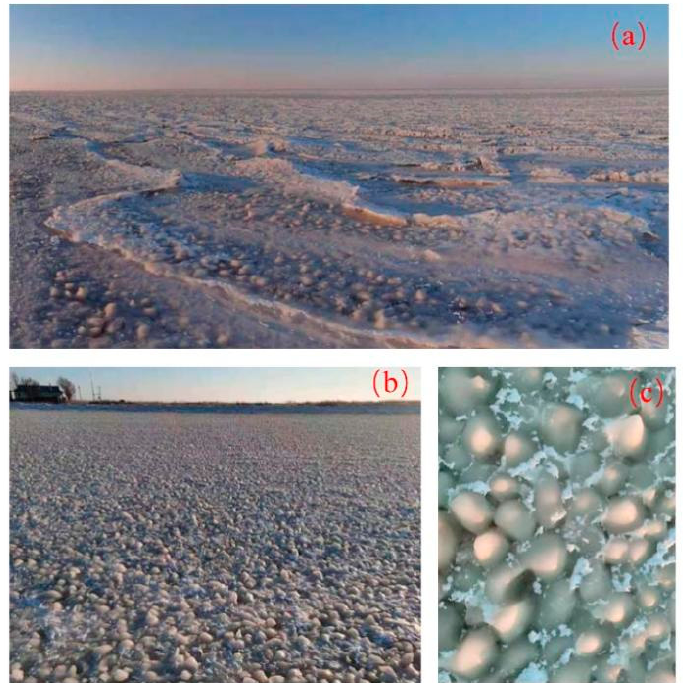
Figure A1. The field photos of lake ice captured around the southern side of Chagan Lake on 20 December 2020: ( a ) long-range view; ( b ) short-range view; ( c ) vertical view.